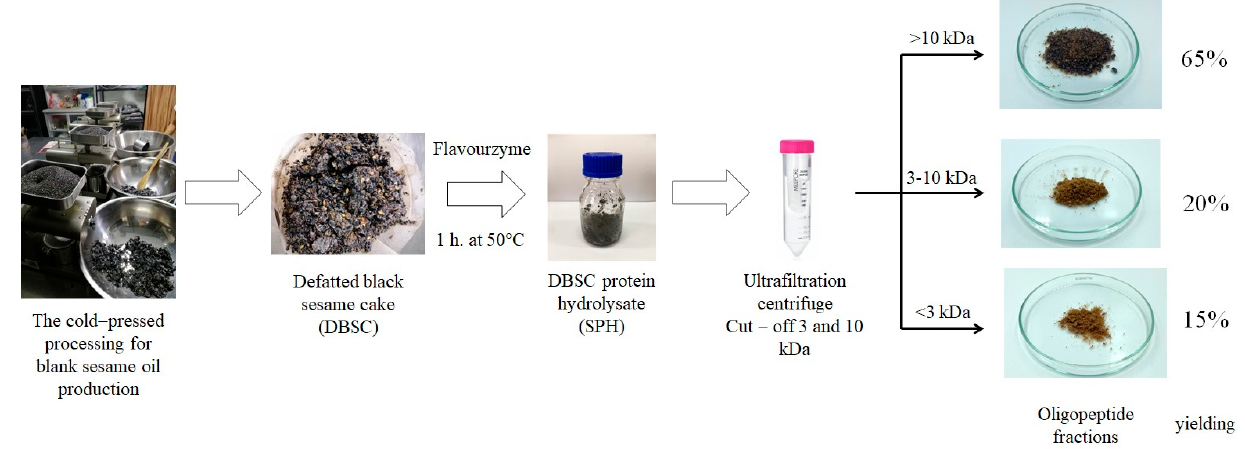
Figure 2. The processing of oligopeptide fractions from SPH.